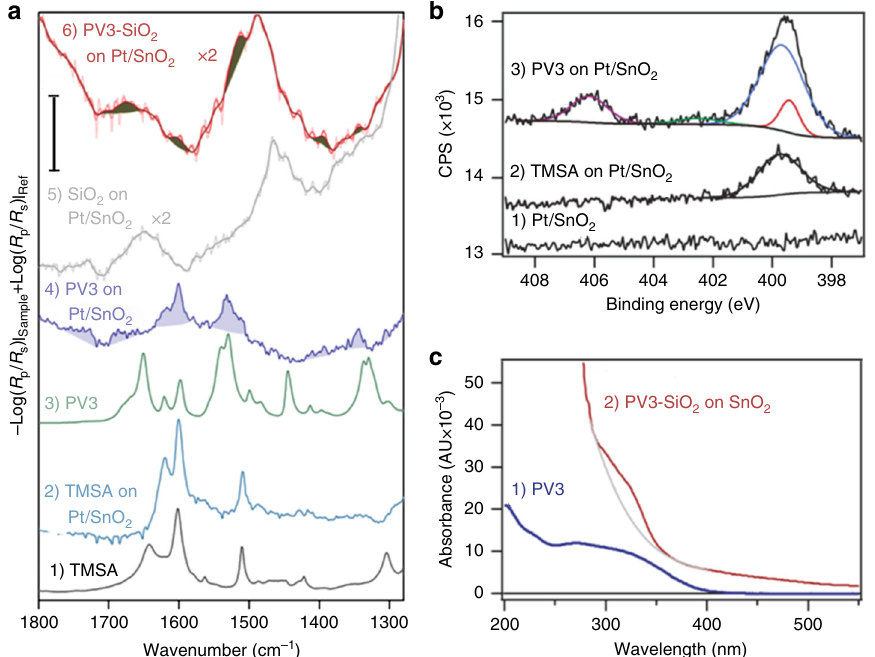
Fig. 3 Spectroscopic characterization of PV3 wire attachment and casting into SiO 2 . a FT-IR characterization. (1) Absorbance spectrum of TMSA powder in KBr. Scale bar is 0.008. (2) IRRAS of TMSA anchored on Pt/SnO 2 (using Pt/SnO 2 as reference) at 2 cm − 1 resolution, computed as the negative log of